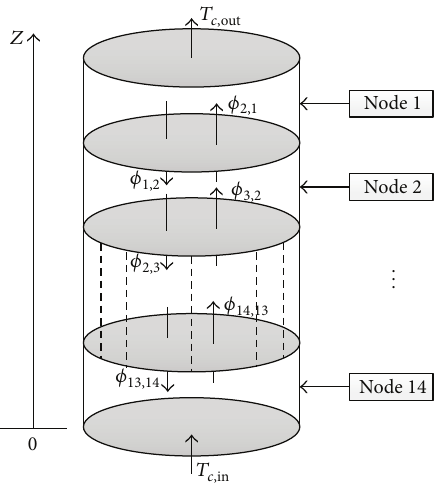
Figure 1: Nodalization of the AP1000 reactor core in the axial direc-